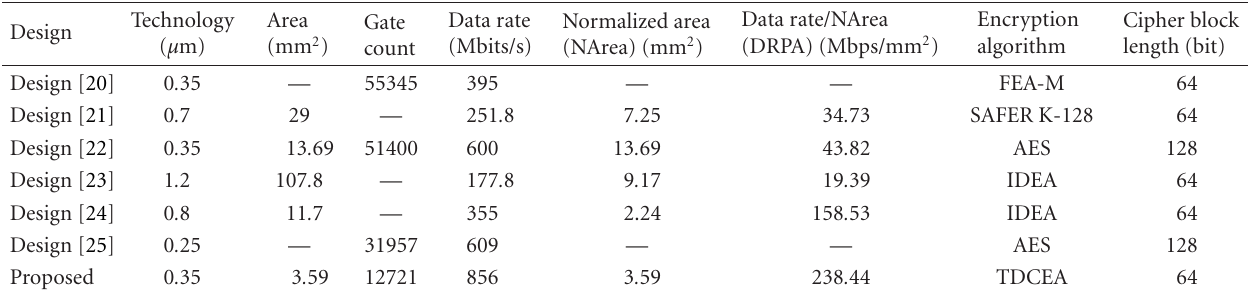
Table 9: Comparison of the proposed design with the existing designs [20, 21, 22, 23, 24,